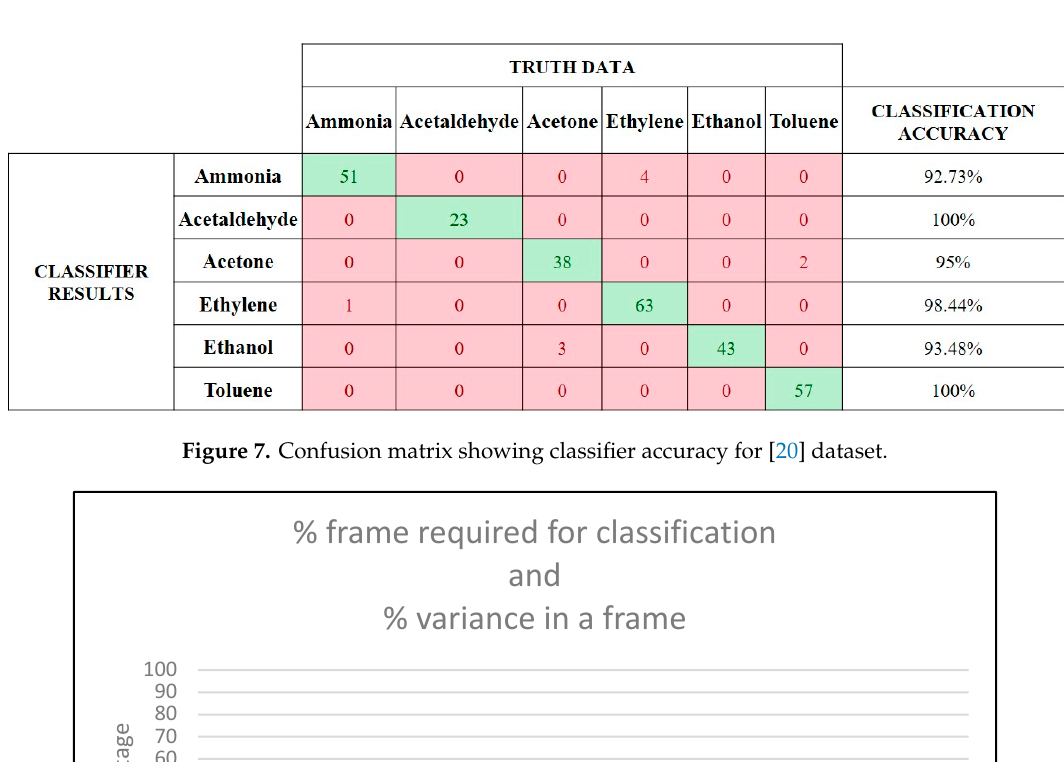
Figure 8. Graph plot to analyze the dependency of pattern-frame required for classification on inconsistencies in rank-order patterns observed for experiments conducted with [20] dataset .